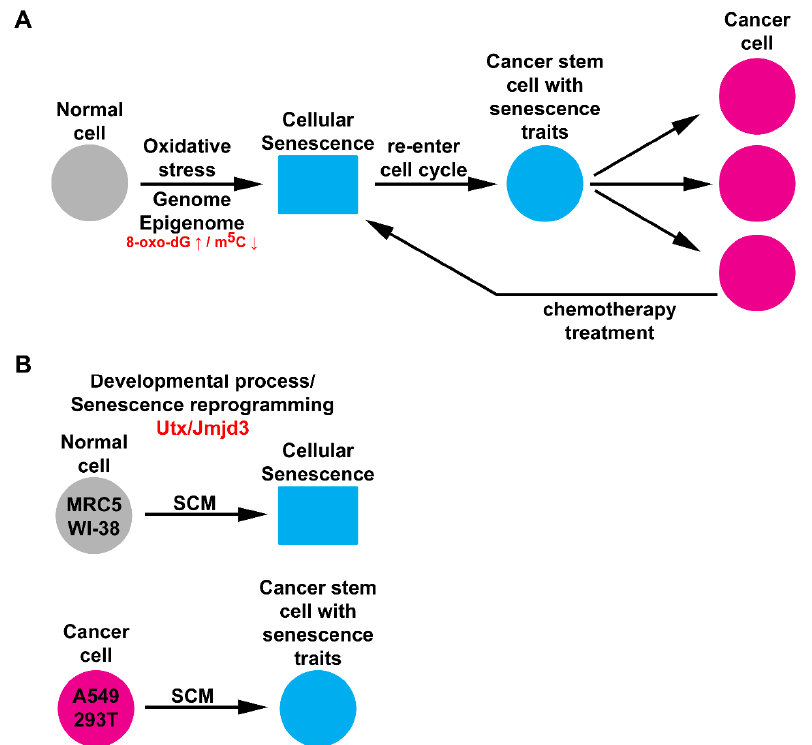
Figure 7. Graphical summary. ( A ) The concept of cancer development arising from the bypass of cellular senescence. Normal cells under oxidative stress accumulate genomic and epigenomic damage (8-oxo-dG ↑ and m 5 C ↓ ) that leads to cellular senescence. Cancer cells treated with chemotherapy can also produce senescent cells, which are essentially dormant tumor cells. It is poorly understood how senescent cells can re-enter the cell-cycle to produce cancer stem cells with senescence traits. Ultimately, cancer cells that are produced from this process contribute to tumor relapse and progression. ( B ) Data arising from this study show that SCM activates cellular senescence in MRC5 and WI-38 fibroblasts. Histone demethylases, Utx and Jmjd3, facilitate a developmental process, overlapping with senescence reprogramming. In comparison to normal cells, A549 and 293T cancer cells cultured in SCM are converted to cancer stem cells with senescence